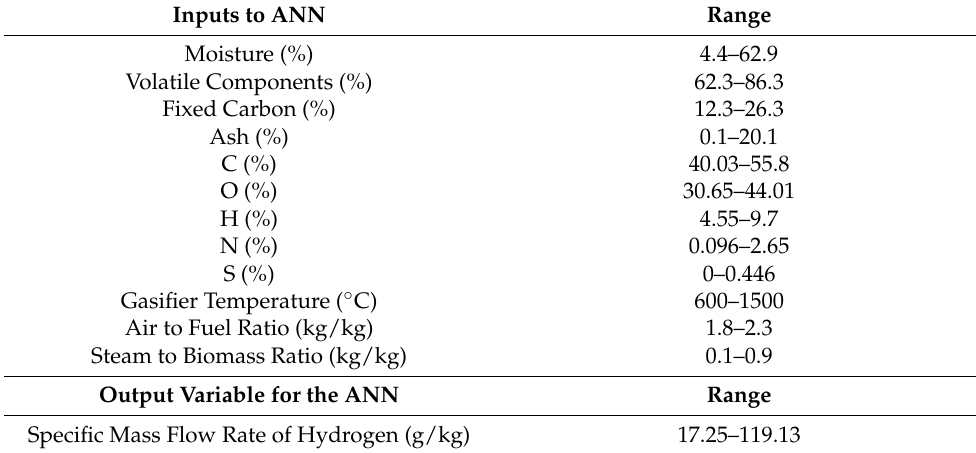
Table 1. The range of input and output variables in the ANN